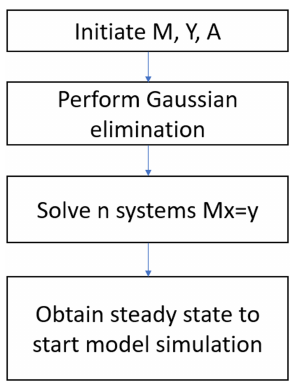
Figure 1. Algorithms and procedures of the new spin-up